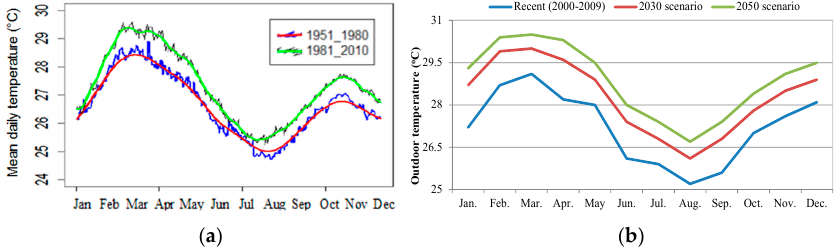
Figure 1. ( a ) Mean daily temperature profile for Ghana for different periods. Adapted from ref. [37]. The black and blue lines give the precise values, while the corresponding green and red smoothened lines display the trends of the values. ( b ) Profiles of outdoor air temperatures for Accra for 2000–2009 (recent), and for 2030 and 2050 (projected) climates under the Special Report on Emission Scenarios (SRES) A1B scenario, obtained from Meteonorm global climate database